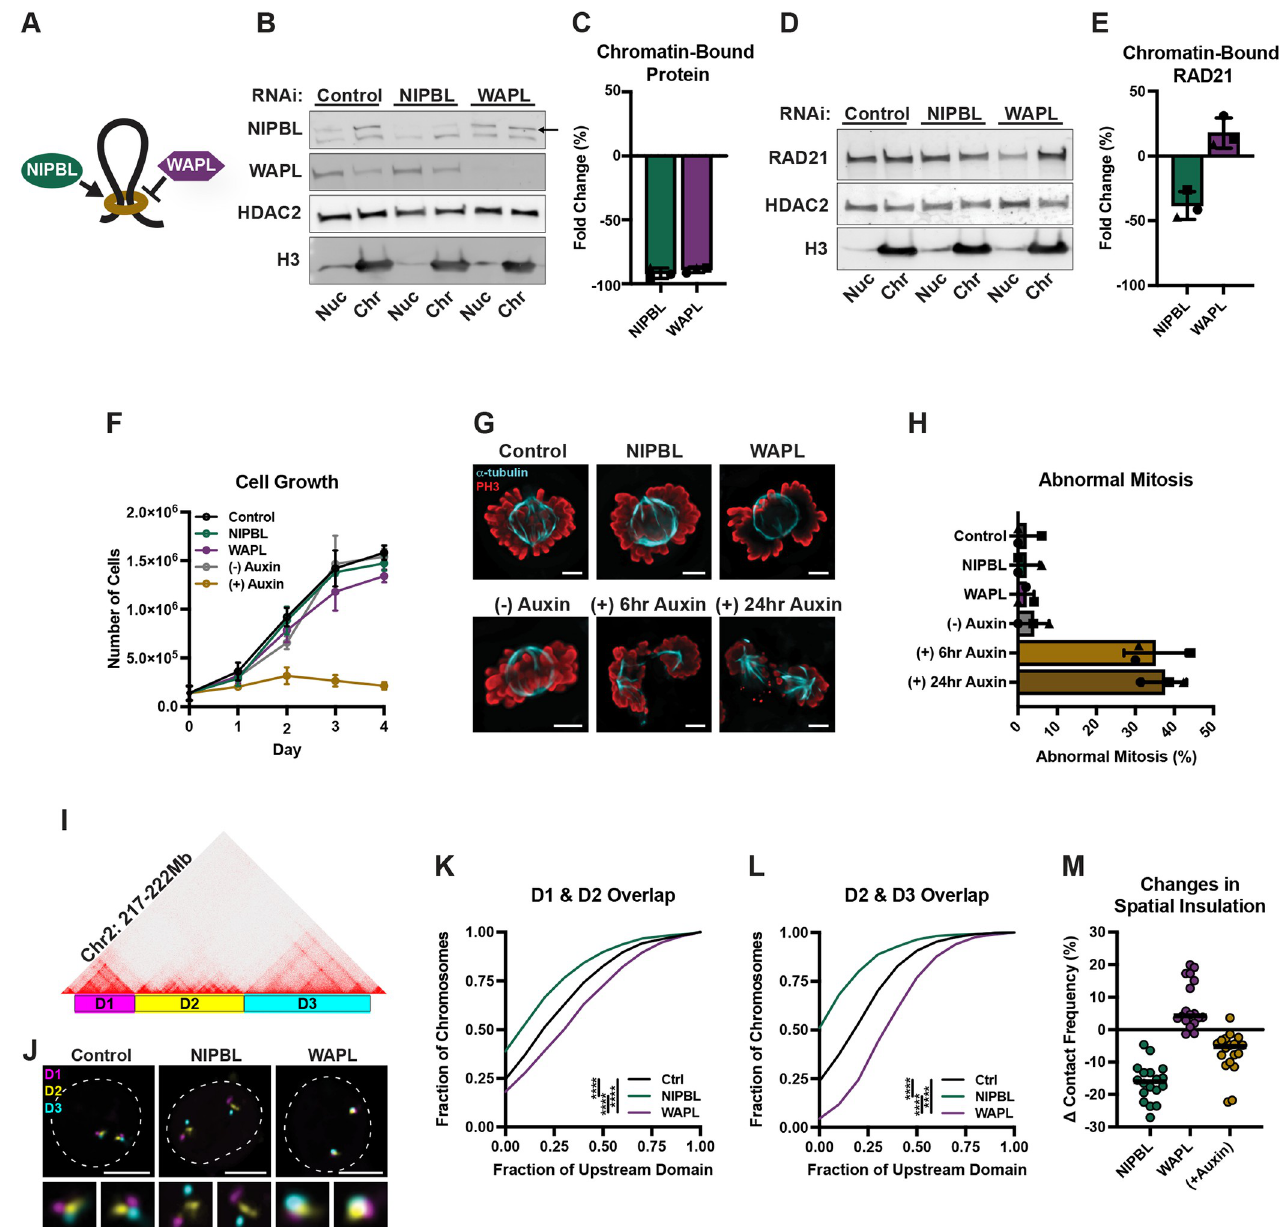
Fig 1. Partial depletion of NIPBL or WAPL separate the role of cohesin in chromatin folding from chromosome segregation. (A) Cartoon depicting the roles of the two opposing cohesin regulators; NIPBL loads cohesin onto chromatin and is required for loop extrusion whereas WAPL opens the ring and removes it. (B) Fluorescent western blot to NIPBL (top band, see arrow) and WAPL in nuclear (nuc) and chromatin-bound (chr) subcellular protein fractionations of RNAi control, NIPBL, or WAPL depleted HCT116 cells. All bands are from the same blot. (C) Mean fold change (%) of NIPBL and WAPL bound to chromatin in each respective knockdown. Each symbol represents a biological replicate, error bars represent standard deviation. (D) Fluorescent western blot to RAD21 in nuclear (nuc) and chromatin-bound (chr) subcellular protein fractionations of RNAi control, NIPBL, or WAPL depleted HCT116 cells. All bands are from the same blot. (E) Mean fold change (%) of RAD21 bound to chromatin in each respective knockdown. Each symbol represents a biological replicate, error bars represent standard deviation. (F) Cell growth measured in 24-hour increments following RNAi or auxin treatment. Each bar represents the mean of 3 biological replicates and error bars represent the standard deviation. (G) Representative immunofluorescence images of mitotic cells stained for α -tubulin (cyan) and phospho-Histone H3 (PH3; red). Top row are HCT116 cells following 72 hour treatment with RNAi against control, NIPBL, or WAPL. Bottom row are HCT116-RAD21-AID cells -/+ auxin for 6 or 24 hours. Scale bar, 5 μ m. (H) Average percentage of abnormal mitotic cells in RNAi control, NIPBL, or WAPL depleted HCT116 cells and HCT116-RAD21-AID cells -/+ auxin for 6 or 24 hours. Each symbol represents a biological replicate, error bars represent standard deviation. (I) Oligopaint design for three neighboring domains at chr2:217-222Mb. (J) Representative FISH images for three domains at chr2:217-222Mb in RNAi control, NIPBL, and WAPL depleted HCT116 cells. Dashed line represents nuclear edge, scale bar, 5 μ m (above) or 1 μ m